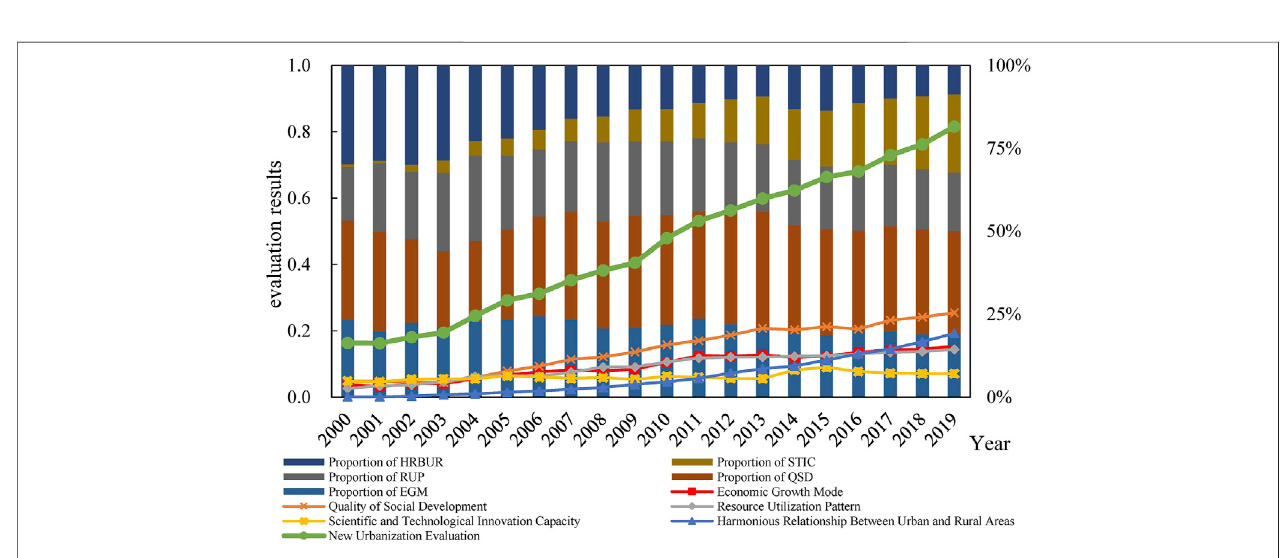
FIGURE 3 | Comprehensive evaluation results of new urbanization in Hebei Province from 2000 to